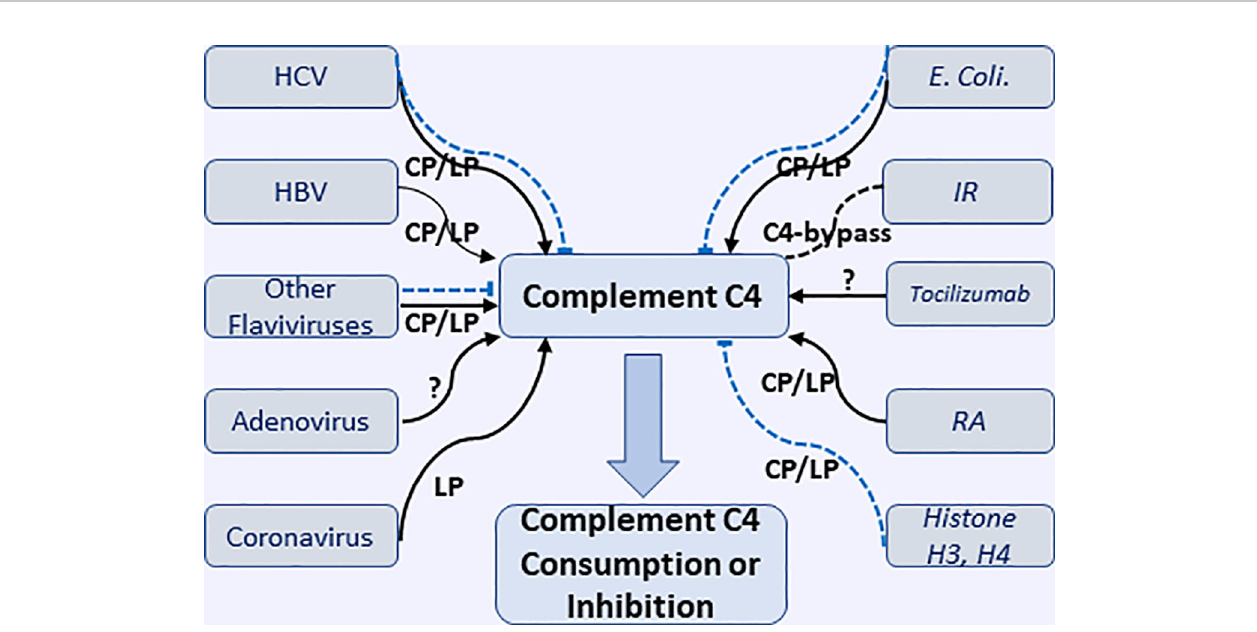
FIGURE 2 | Interactions of various microorganisms (including viruses and E. coli.) and pathological conditions with complement C4 to cause consumption or inhibition of complement C4 through classical, lectin, and unde fi ned pathways. HCV, hepatitis V virus; HBV, hepatitis B virus; IR, ischemia reperfusion; RA, rheumatoid arthritis. Black solid arrow represents the activation of complement C4; Blue dash line represents the inhibition of complement